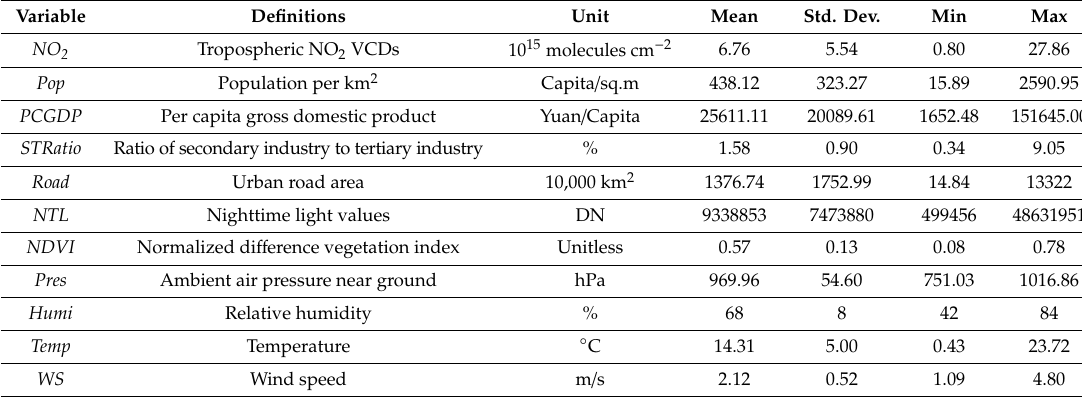
Table 1. Descriptive statistics for